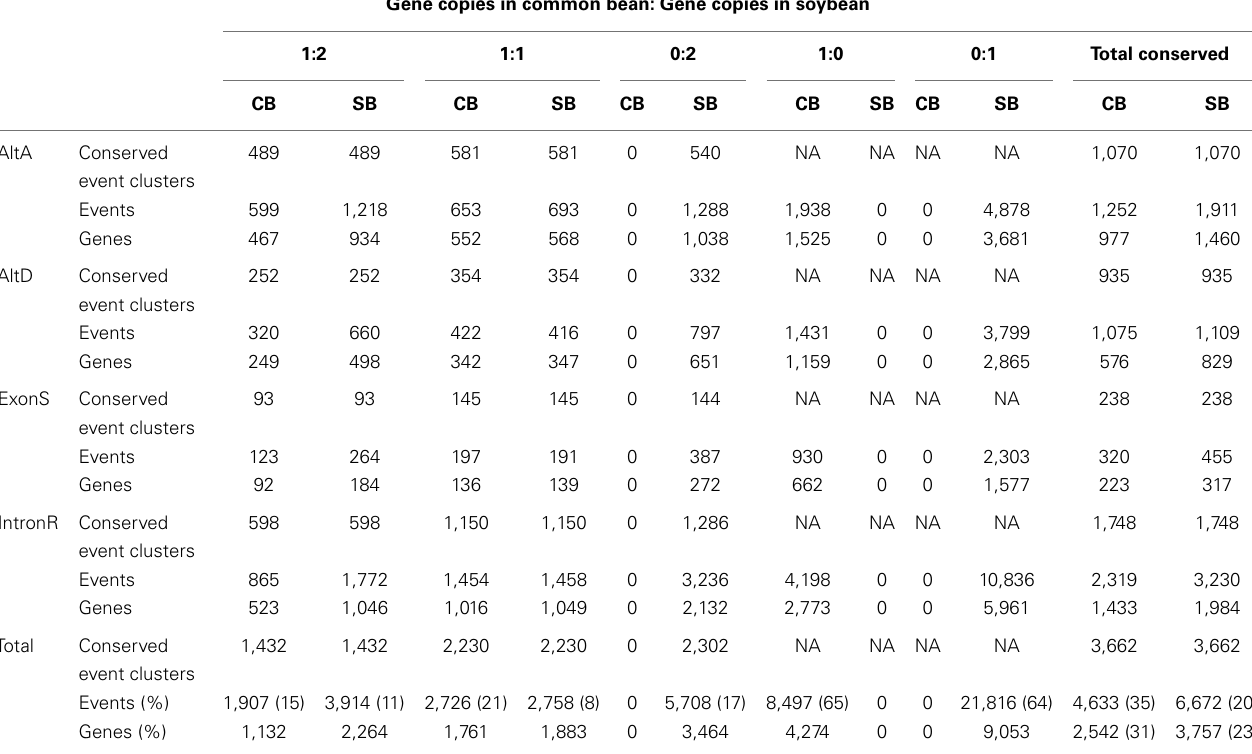
Table 3 | ConservedAS events inWGD orthologs .